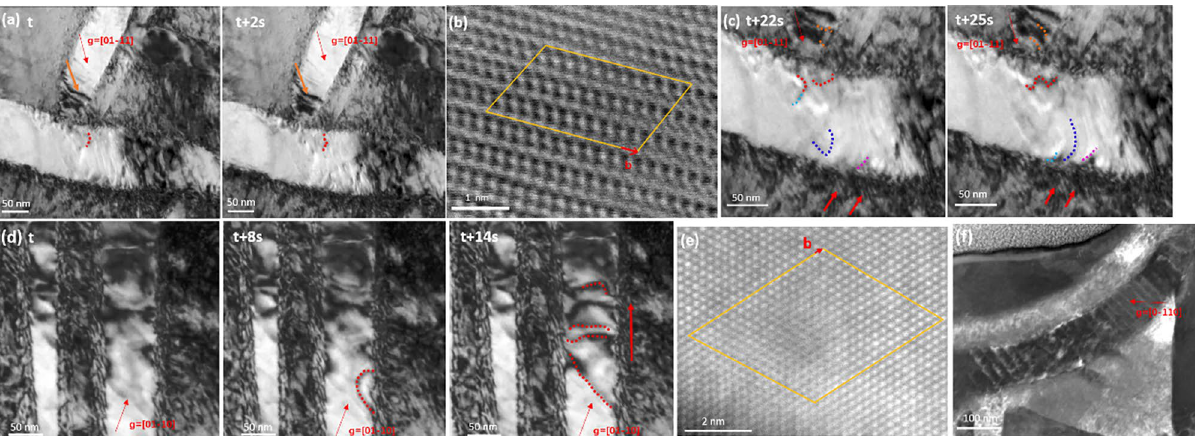
Figure 3. Dislocations glide along longitudinal direction. ( a ) Dislocations were excited from α–α junction and moved along the longitudinal direction of α plates. ( b ) The characteristic of dislocation in α phases along longitudinal direction. ( c ) Dislocations activities were excited from α–α junction and moved in multiple directions. ( d ) Dislocations activities at the α–β boundary and their movement along α phase. ( e ) The characteristic of dislocation near α–β phase boundary ( f ) Post-mortem STEM image showing the glide of dislocations along the longitudinal direction of α plates in bulk counterpart as